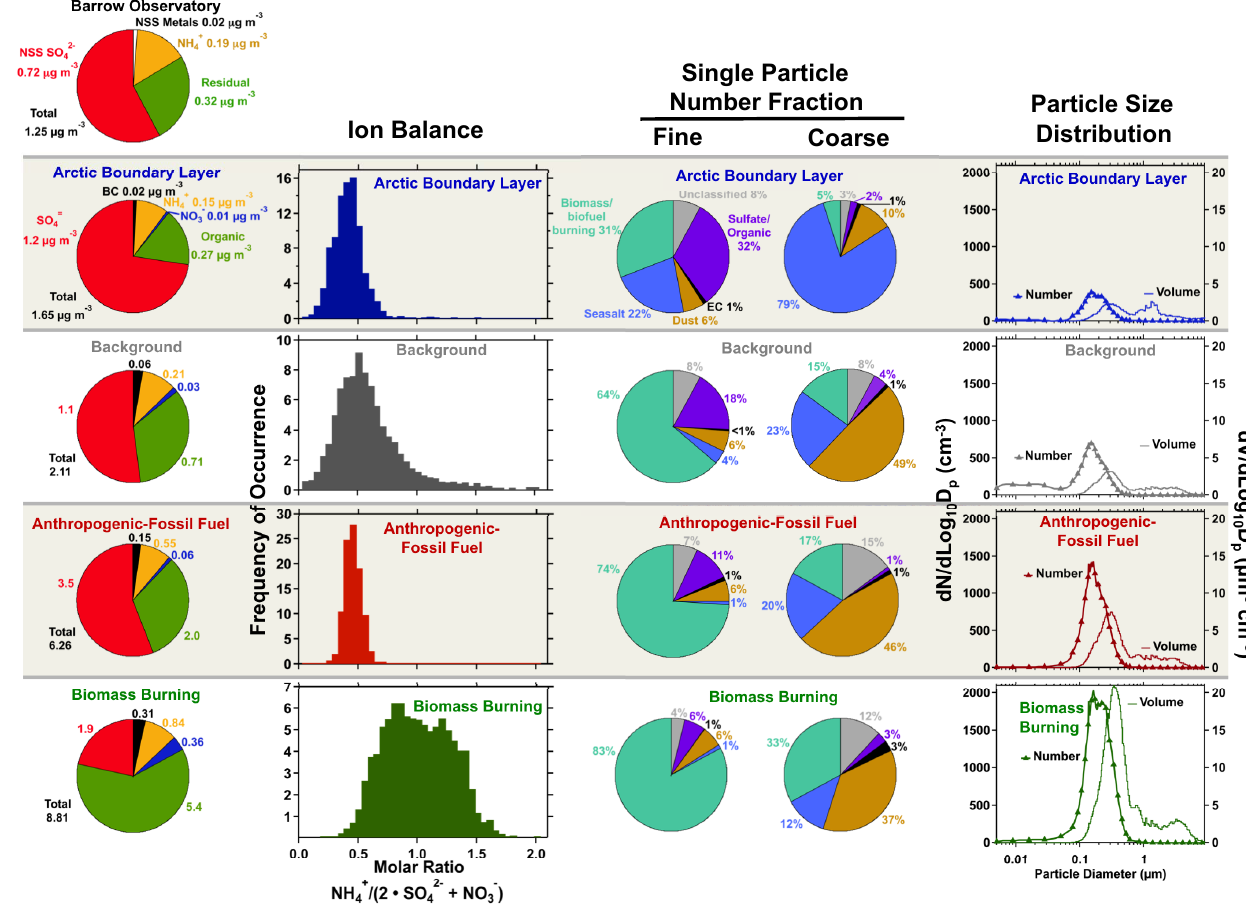
Fig. 7. Average composition and size distributions apportioned into the 4 airmass categories. Left column: bulk composition for submicron particles (OA=organic aerosol; BC=black carbon). First pie chart contains submicron particle mass from 1997–2000 from the NOAA Observatory at Barrow, Alaska (Quinn et al., 2002); NSS=non sea-salt; residual=unspeciated mass (probably organic); sea-salt components not shown. Second column: approximate charge balance from major ions as determined by the AMS. Third and fourth columns: number fraction of particles with diameters from 0.15–0.7µm and 0.7–3µm, respectively, placed into 6 compositional categories based on single particle mass spectra measured by the PALMS instrument (EC=elemental carbon). Right column: particle number (symbols, left axis) and volume (line, right axis) size